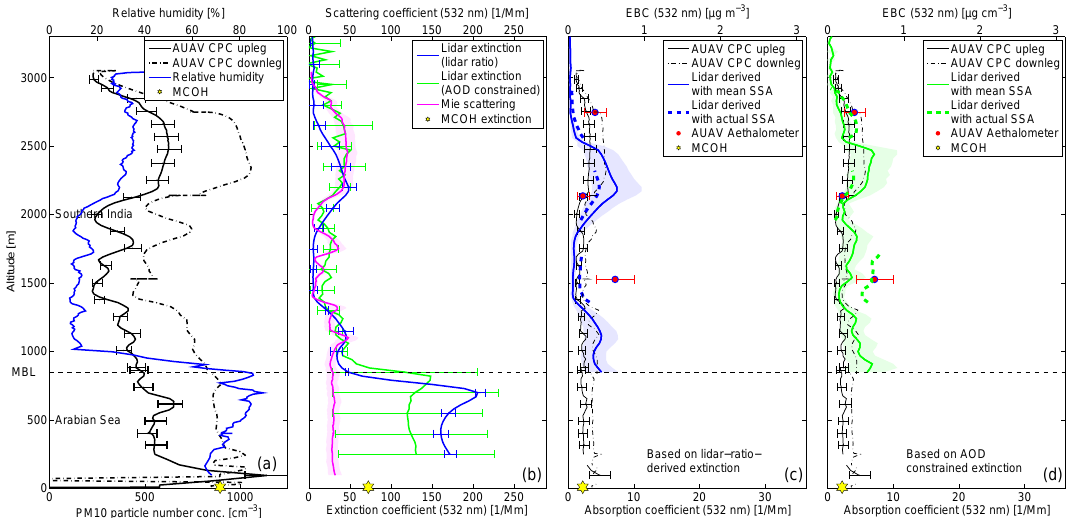
Figure 7. 4 March 2012. (a) Profile of PM 10 particle number concentration measured by AUAV CPC for upleg (black solid) and downleg (black dashed) flights and relative humidity profile (blue). (b) Profile of particle extinction coefficient measured with the miniMPL (blue), scattering coefficient calculated with Mie theory (magenta). (c) Profile of particle absorption coefficient and EBC measured by an onboard aethalometer (red dots), estimated from lidar measurements (blue) with mean SSA and 50% uncertainty (blue shading), estimated from lidar measurements with actual SSA (blue dashed) and AUAV CPC approach (black). (d) Same as (c) but with lidar extinction coefficient constrained by AERONET AOD (green and green